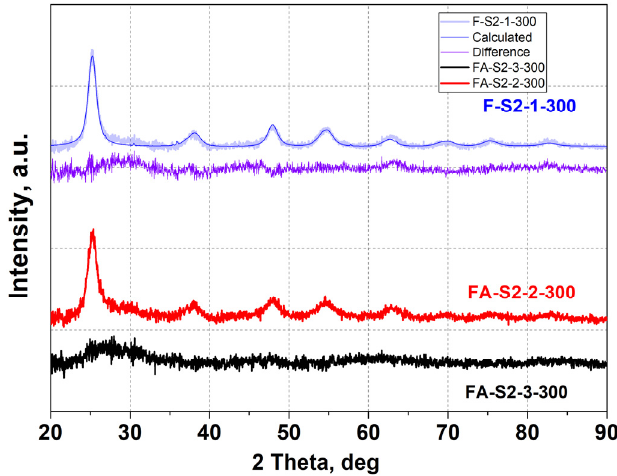
Figure 4. X-ray diffraction patterns of samples: (1) FA-S2-1-300, (2) FA-S2-2-300, (3) FA-S2-3-300 with Rietveld refinement.